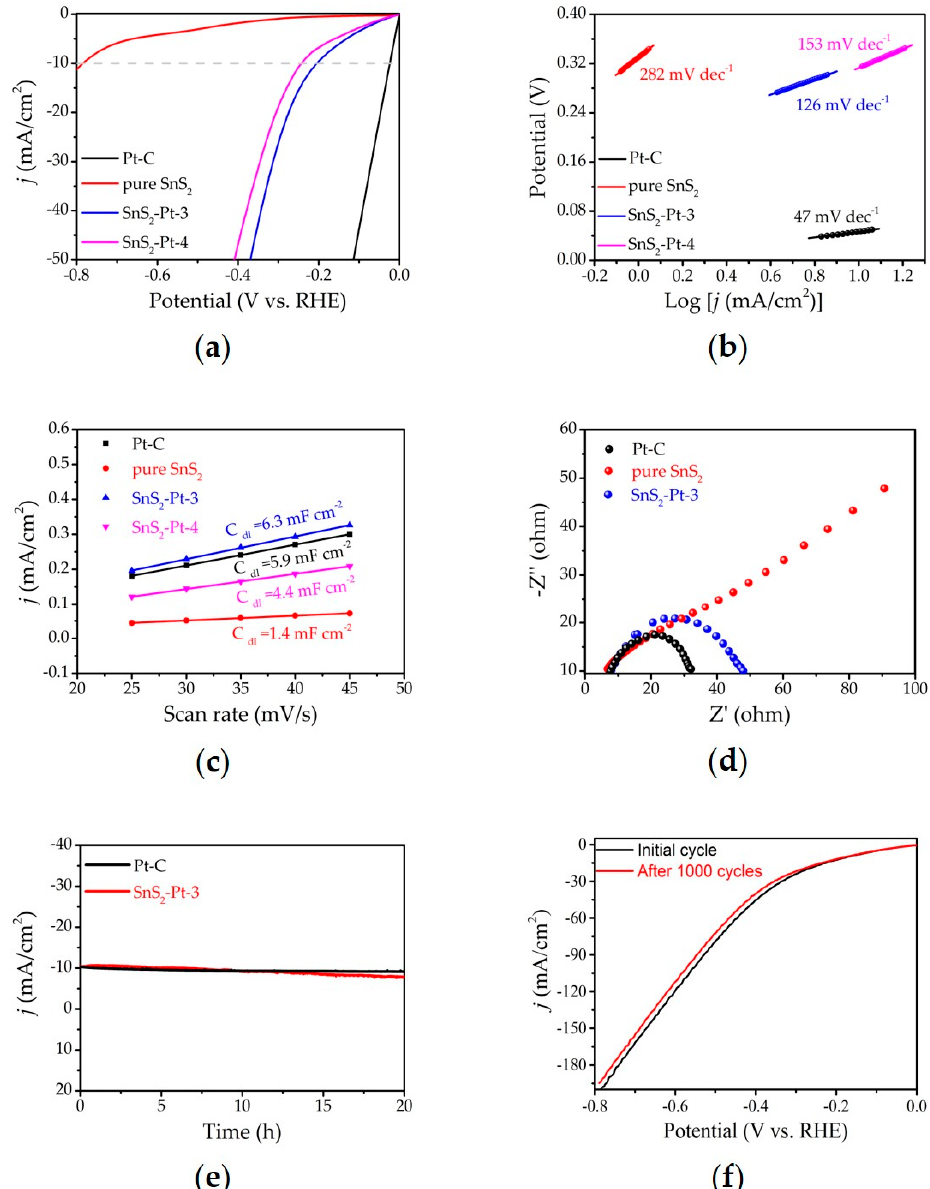
Figure 4. HER of the SnS 2 -Pt-3. ( a ) LSV curves of the commercial Pt/C, the pure SnS 2 nanosheets and the SnS 2 -Pt-3 ones. ( b ) Tafel plots corresponding to ( a ). ( c ) Electrochemical active surface area with different mass ratio. ( d ) EIS measurement of pure SnS 2 and SnS 2 -Pt-3. ( e ) I-T distribution diagram of SnS 2 -Pt-3 nanosheets. ( f ) LSV curves of the SnS 2 -Pt-3 before and after 1000 potential cycles.